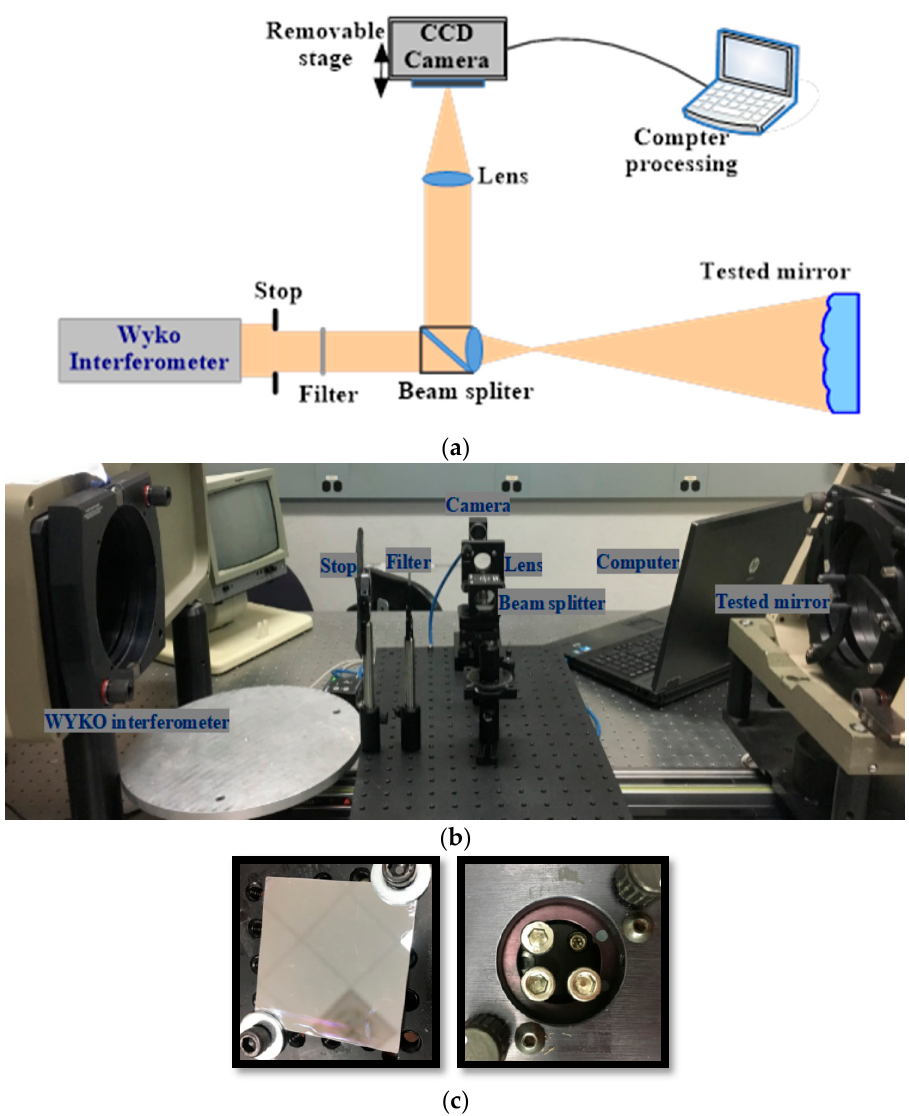
Figure 2. ( a ) The diagram of the measuring installation with the course of the clearance beams; ( b ) the experimental setup of the PR system; and ( c ) the thin measured mirror. The left is the front surface of the thin measured mirror and the right is the back surface of the thin measured mirror. Three screws were used to apply different forces to the measured mirror to change the surface shape.